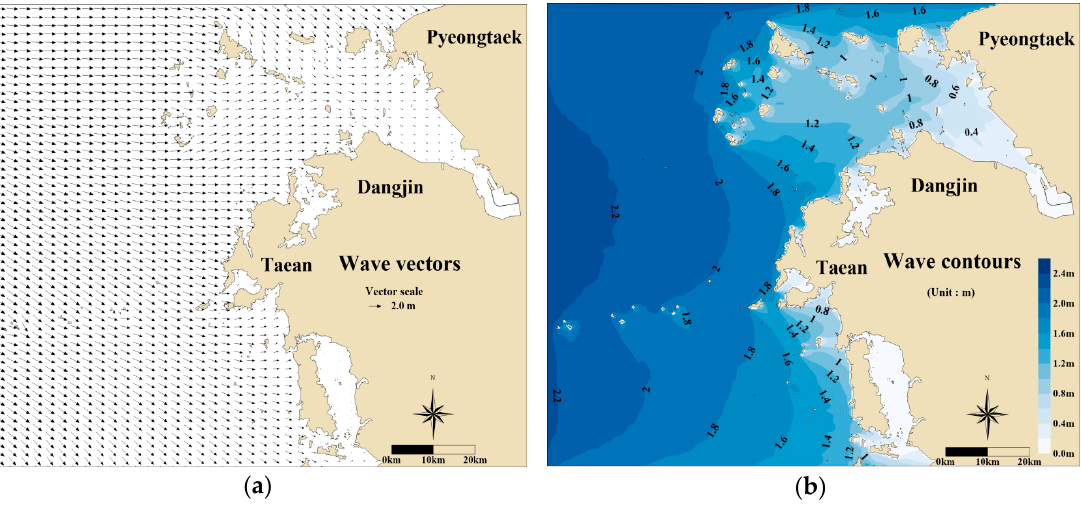
Figure 15. ( a ) Wave vector and ( b ) co-wave height map.